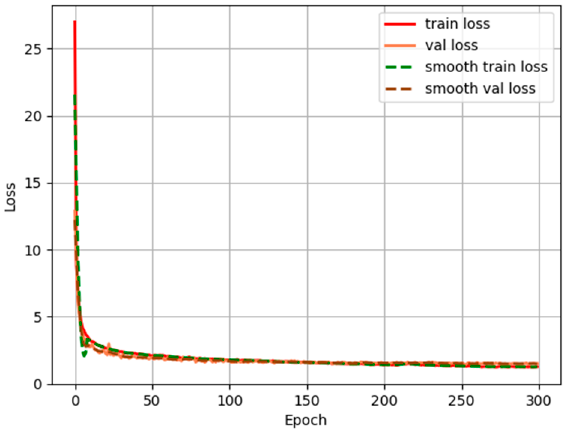
Figure 10. LOSS function change curve.